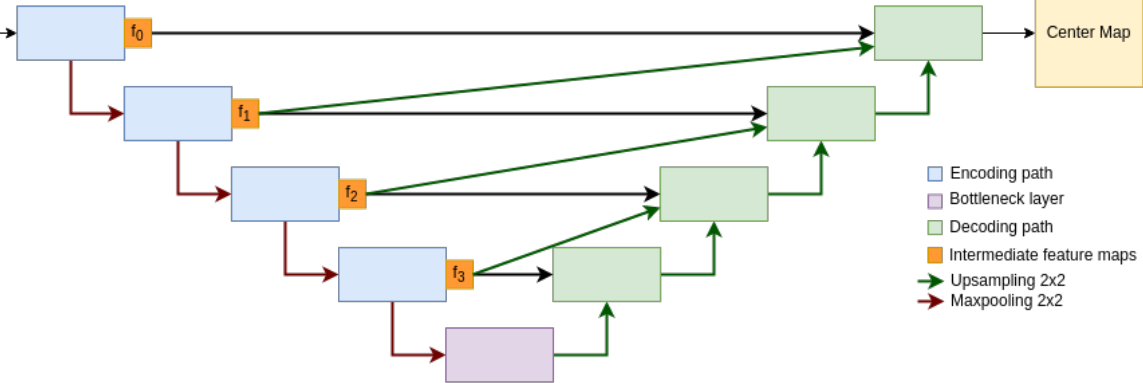
Figure 2. Selected Up-Net architecture [49] for the generator network. The network has 4 main parts, (1) the encoding path generates rich features to represent the input image, decreasing the resolution, (2) the bottleneck layer, (3) the decoding path increases the resolution of the generated features and generates the final output, (4) the skip connections provide high spatial resolution to the decoding path. Each convolutional block is composed of three convolutions (with kernel size 3, each one followed by a Batch Normalization layer [55] and with ReLU activation). Green arrows depict the upsampling layers, which are composed of a first bicubic upsampling of the feature maps that doubles the resolution and is followed by a convolutional layer that halves the number of channels, Batch Normalization and ReLU